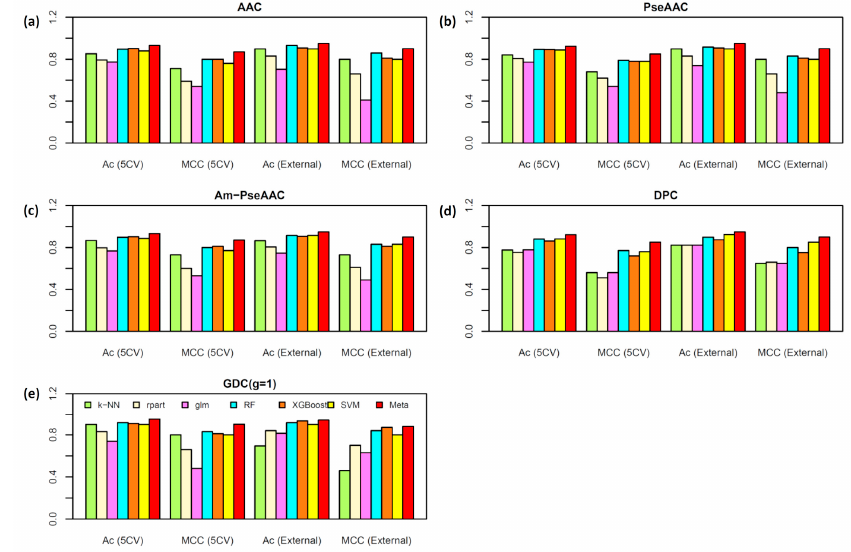
Figure 5. Performance comparisons of AVP predictors based on different six machine learning algorithms types of features, i.e., AAC ( a ), PseAAC ( b ), Am-PseAAC ( c ), DPC ( d ), and GDC ( e ), on the dataset T 544p+544n + V 60p+60n , respectively.